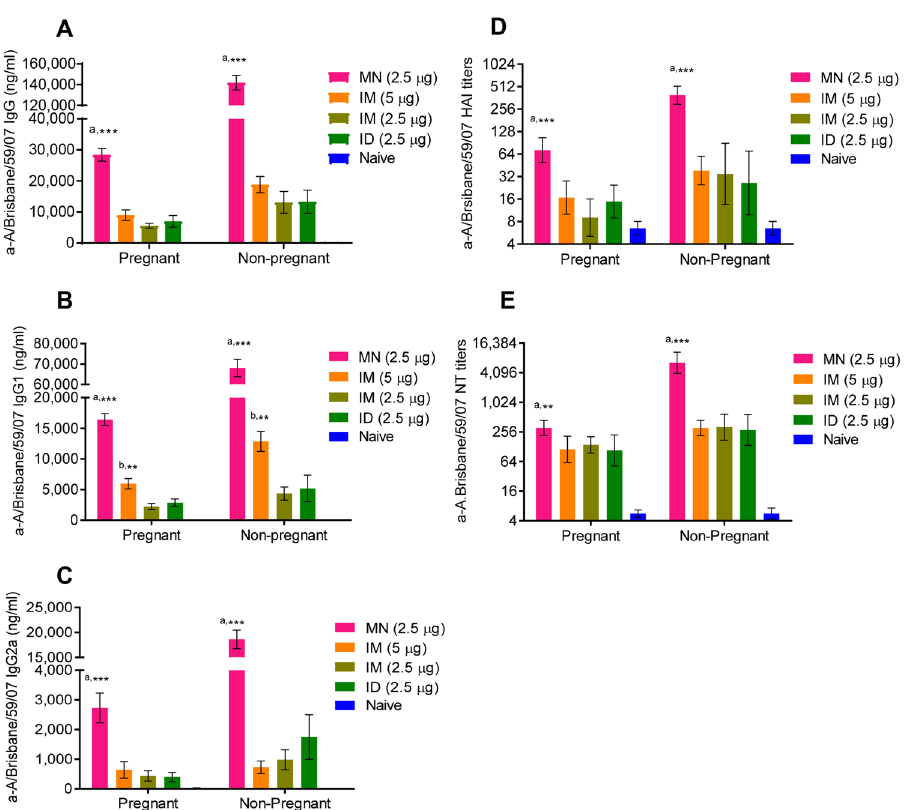
immunization with a higher vaccine dose in pregnant and non-pregnant mice respectively, demonstrating signif- icant dose sparing (Fig. 2E) (Supplementary Table 1).